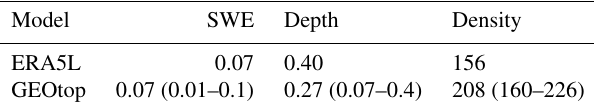
Table 4. Comparisons of September to March average snow water equivalent (SWE; m), depth (m), and density (kgm − 3 ) near Lac de Gras for ERA5L and a GEOtop simulation driven by